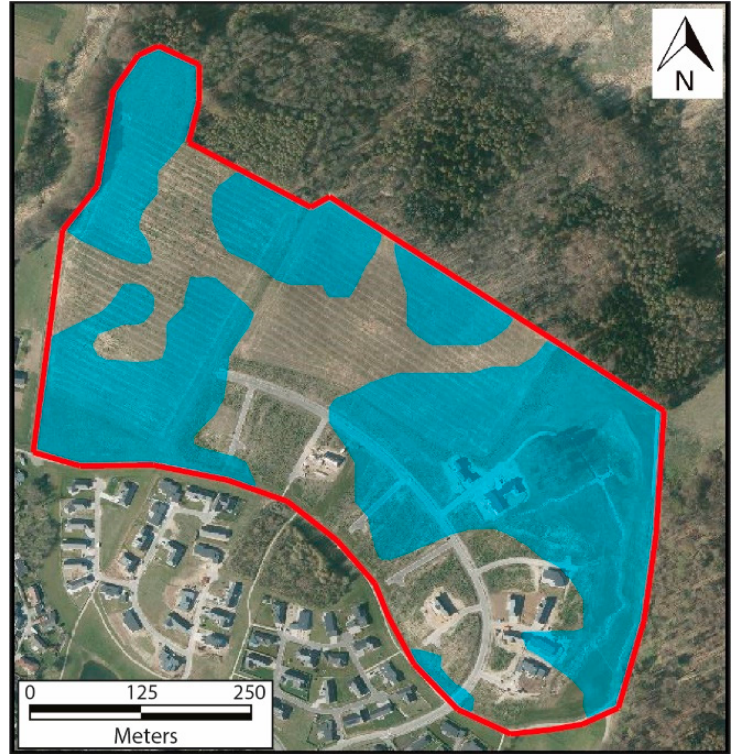
Figure 9. Areas marked with blue are found to be suitable areas for infiltration.